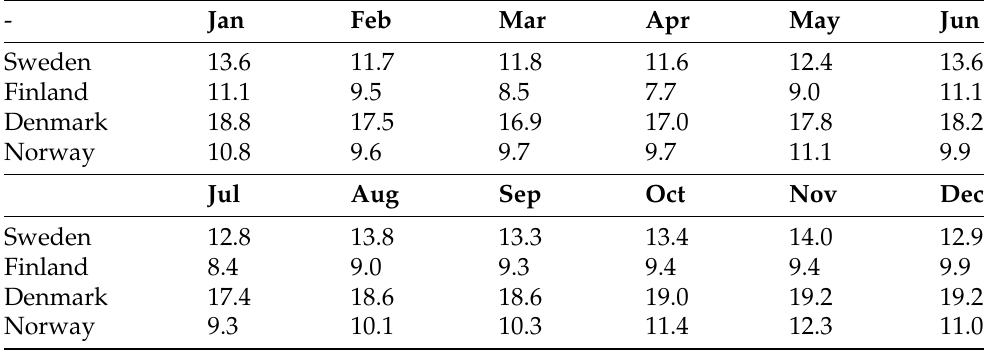
Table 3. The standard deviation of average hourly consumption divided by average hourly consump- tion. Figures in